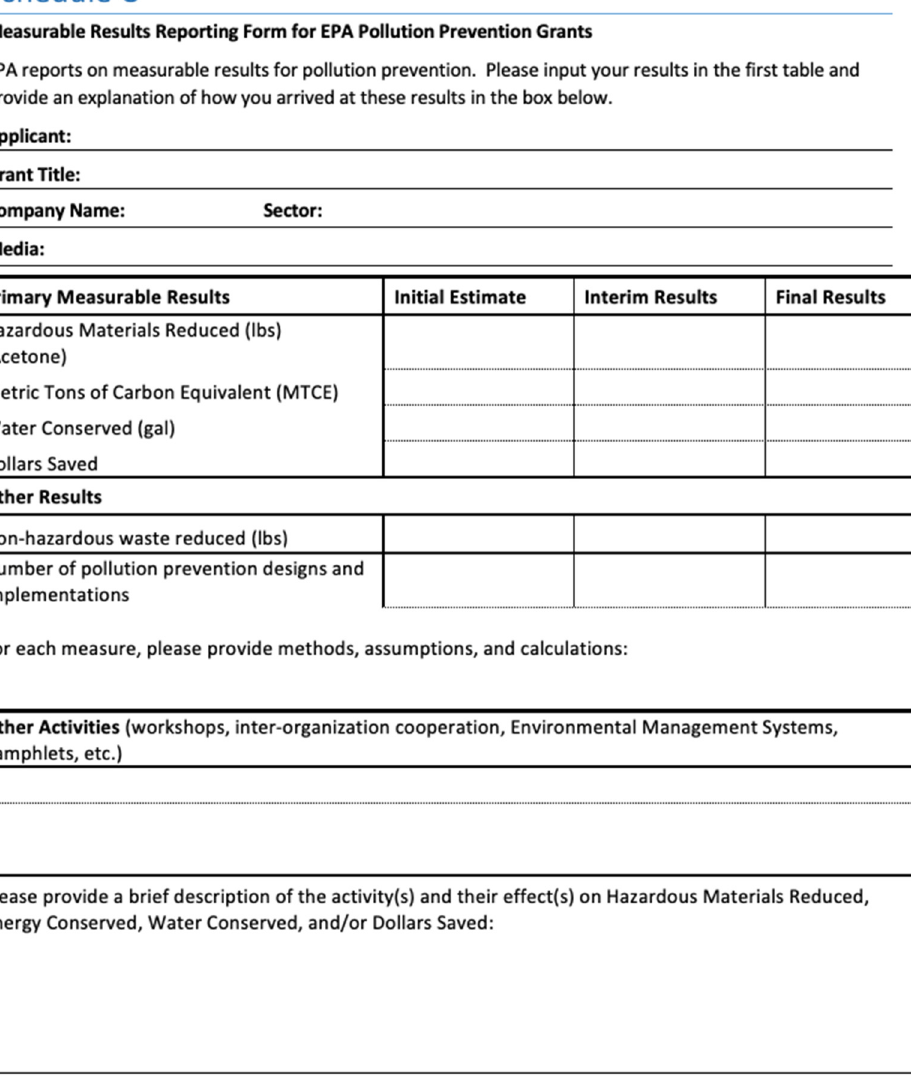
Figure A1. Example of a schedule C.